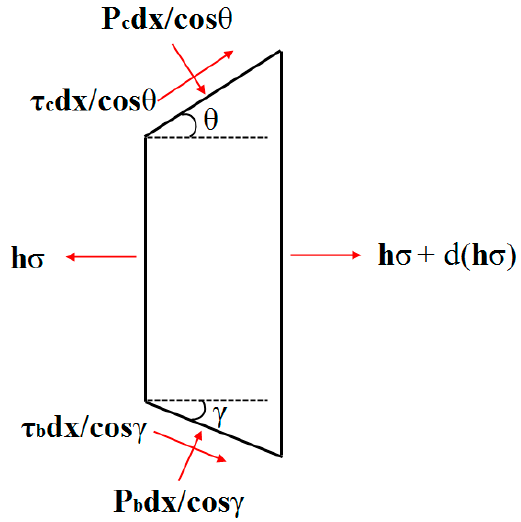
Figure 5. Stress state of micro-element in region IV.